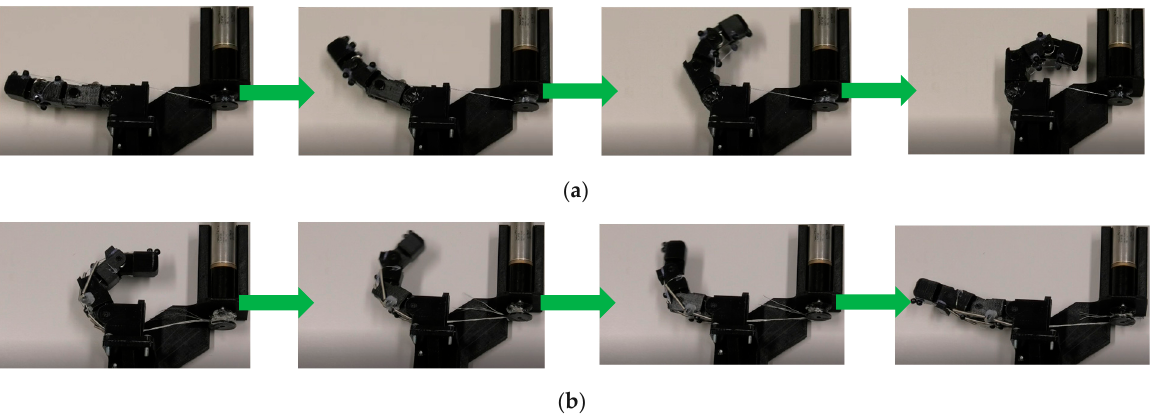
Figure 6. ( a ) Flexing the artificial finger (AF-F) from the extension position using the proposed flexion routing configuration. ( b ) Extending the artificial finger (AF-E) from the flexion position using the proposed extension routing configuration.